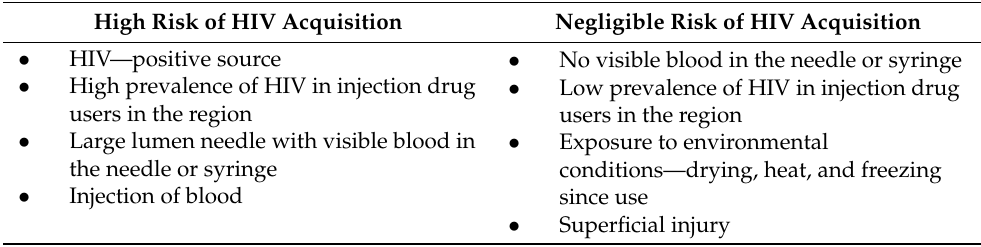
Table 1. Risk of HIV acquisition after needlestick injury